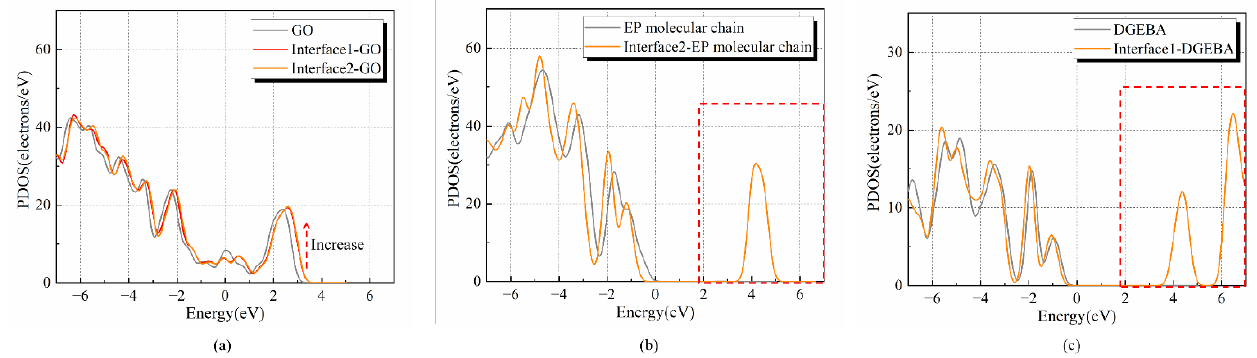
Figure 5. Comparison of the PDOS distribution between EP and GO molecules in interfaces: ( a ) PDOS distribution of GO alone and GO at the interfaces; ( b ) PDOS distribution of the EP molecular chain alone and molecular chain at the interface; ( c ) PDOS distribution of DGEBA alone and DGEBA at the interface. (The red dotted line part is the number of electrons in molecular orbitals with high energy.)